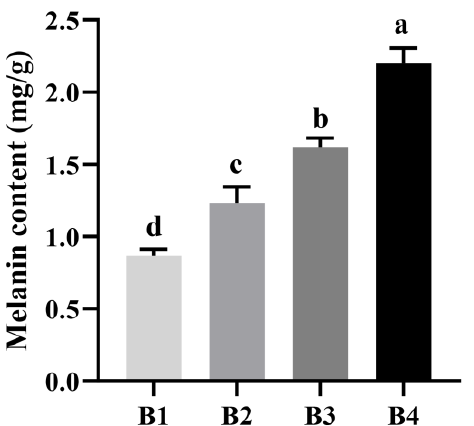
Figure 2. Melanin content in fruiting bodies grown at different light